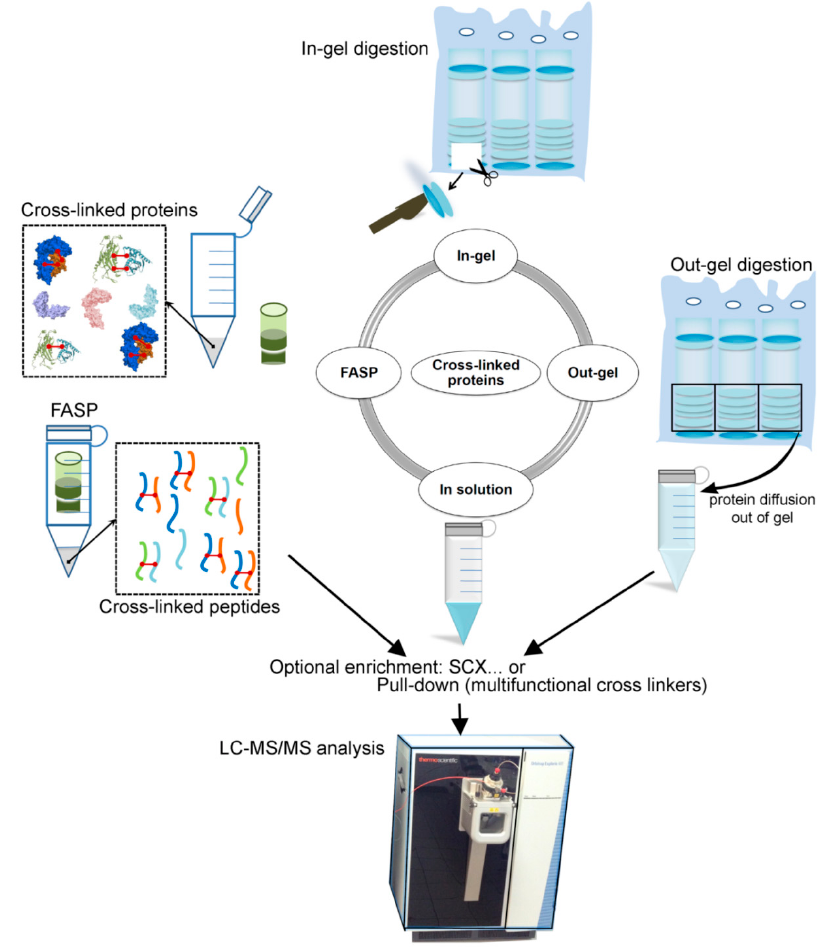
Figure 5. A workflow of determining protein structure, as well as the protein–protein interactions using the most frequent bottom-up cross-linking mass spectrometry. Extracted cross-linked proteins could be turned into peptides by several digestion protocols and proteases. Protein digestion protocol is chosen based upon up-stream steps taken to prepare cross-linked protein extract. FASP (filter aided sample preparation), ‘in-gel’, and ‘out-gel’ digestion protocols are used predominantly when a sample contains mass spectrometry incompatible substances, e.g., detergents or contaminants. However, ‘in-solution’ digestion might be used along with proteomic samples, which are already mass spectrometry compatible and contain predominantly cross-linked proteins of interest. Complexity of the cross-linked peptide samples might be reduced by separating cross-linked peptides from linear peptides after digestion. Difference in physico-chemical properties of cross-linked and linear peptides is often exploited to perform strong cation exchange or separation based on difference of peptide size. Alternatively, cross-linked peptides could be pulled down if a linker containing an affinity tag such as for example, biotin group has been used. Down-stream mass spectrometry analysis is frequently done in data-dependent acquisition mode (DDA). In the figure, representation of protein or peptide structures were prepared using BIOVIA Discovery Studio (Dassault Systèmes, BIOVIA Corp., San Diego, CA, USA) visualizer.